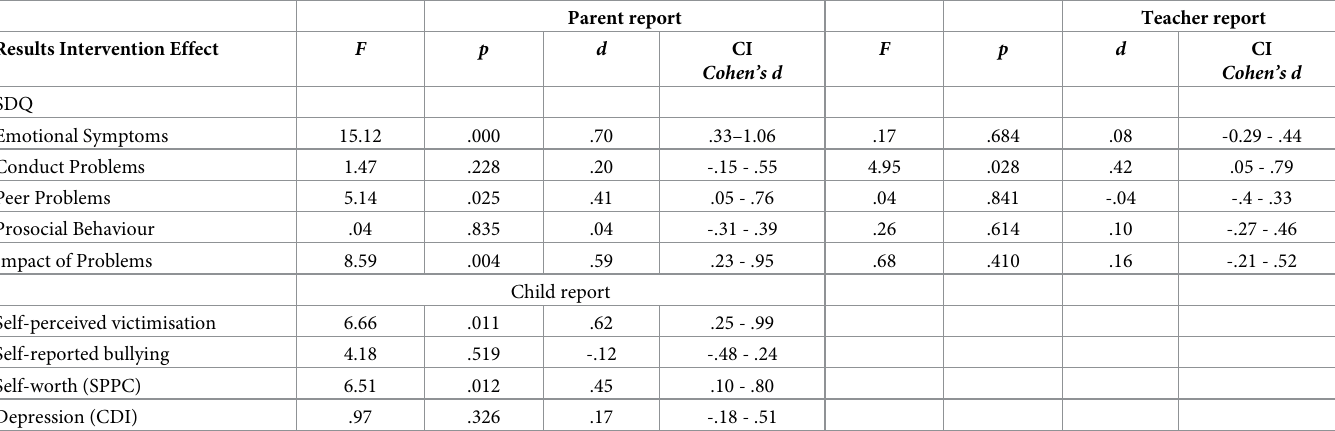
Table 3. Intervention effects: Time by condition interactions in repeated measures